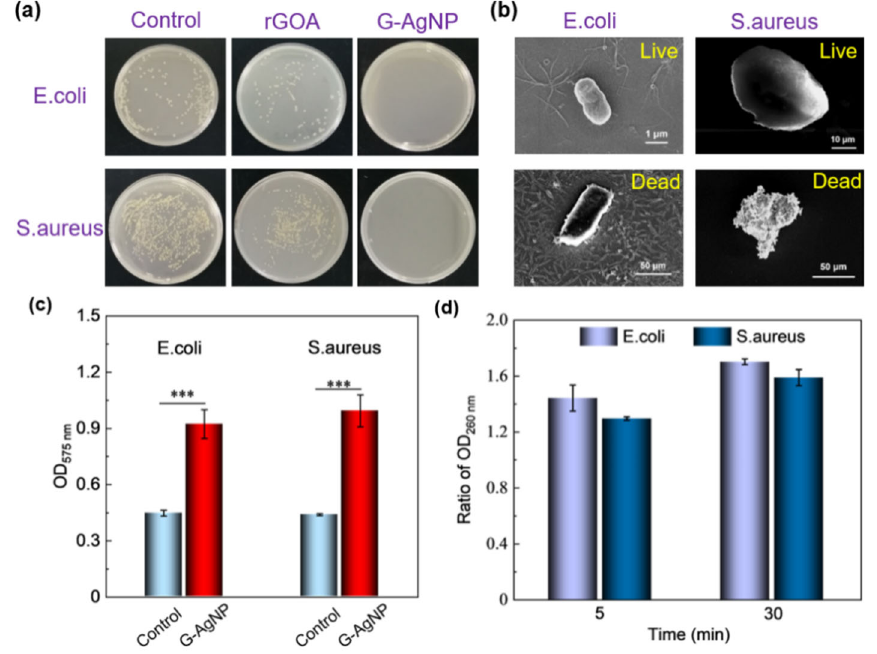
Figure 4. Antibacterial investigation. ( a ) Plates of E. coli and S. aureus after the antibacterial test. ( b ) The comparative morphologies of E. coli and S. aureus before and after the antibacterial test. ( c ) The result for NBT test. *** p < 0.001. ( d ) The cytoplasm leakage